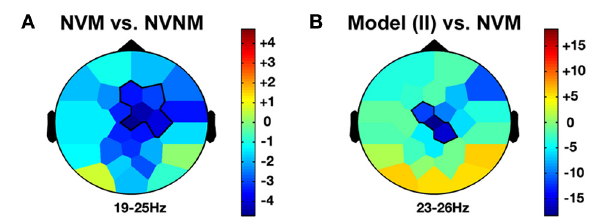
FIGURE 3 | Self-agency and beta frequency band effects. NVM versus NVNM (A) and Model in II versus NVM (B) show a similar decrease of the beta activity (19–26Hz) across the right fronto-central regions. The color stands for the mean t -values across the frequency range of the considered clusters. Statistical clusters are outlined in thick black lines for both representations. II, induced imitation. For other abbreviations, see Figure 2 .